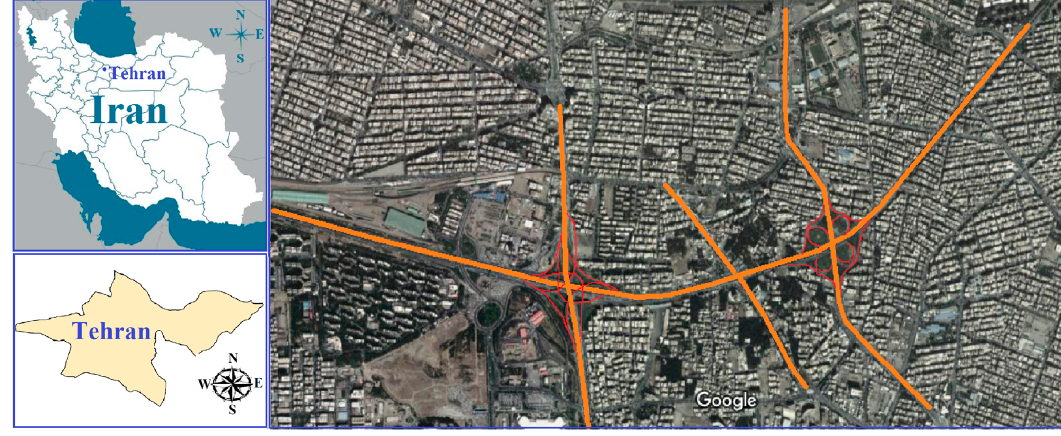
Figure 1. The interchange between Sheikhfazolah and Yadegar highways (Tehran, Iran).